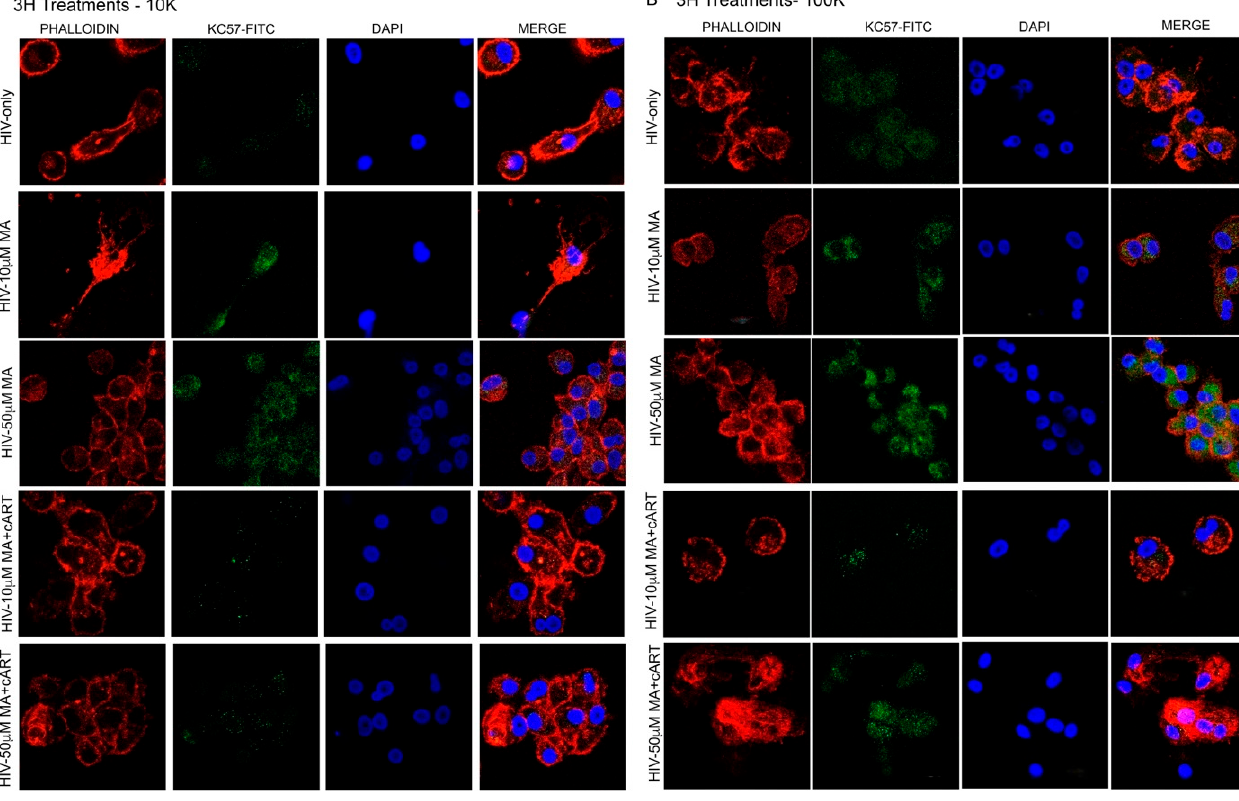
Figure 5. EV from HIV/meth-treated MDM promote syncytia in naïve MDMs. Syncytia formation was observed three hours post-treatment with 10K ( A ) and 100K ( B ) EV. Phalloidin (F-actin stain), Kc57-FITC (HIV core protein marker), DAPI (nucleus marker); scale bar 20 µ m. N = 3 (MDMs from three independent donors).